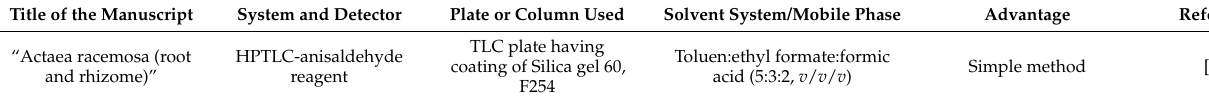
Table 2. Different chromatographic techniques for the evaluation of CR